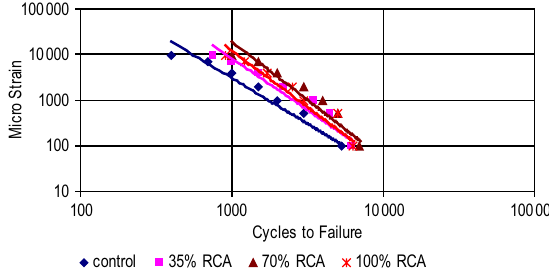
Fig. 5. Comparison of fatigue behavior of different mixes at 40 °C for gradation type A